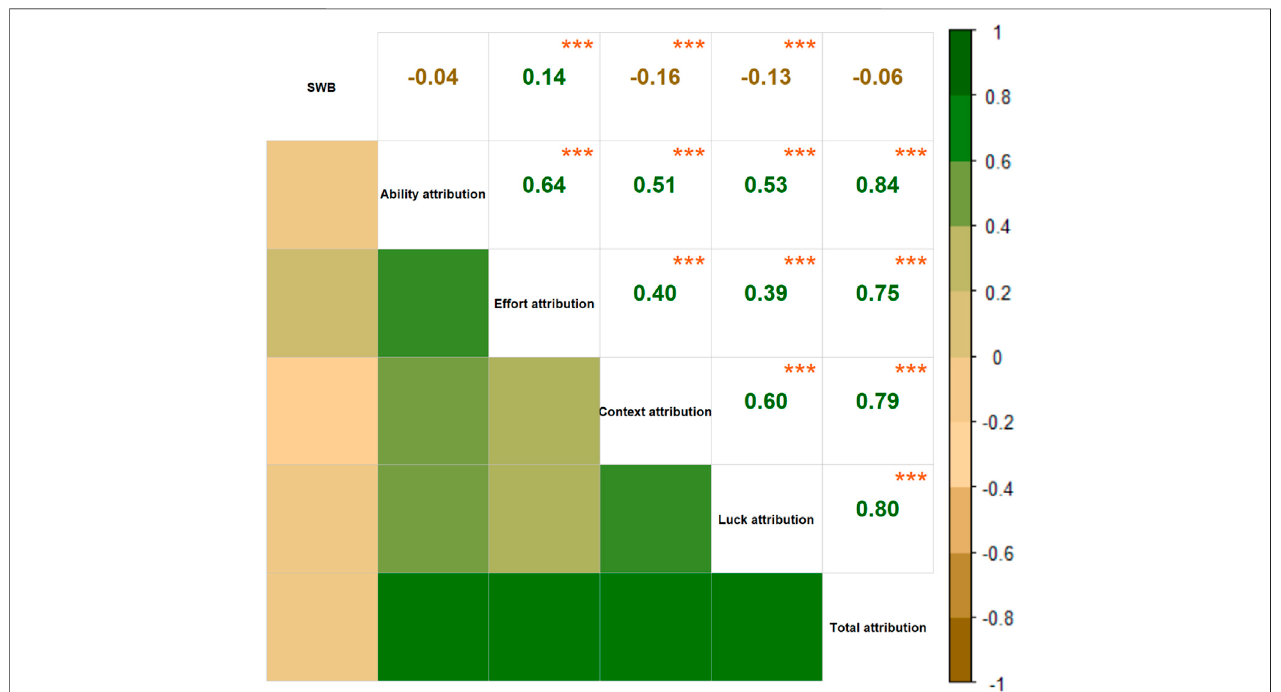
FIGURE 1 | Heat map illustrating correlations between subjective well-being and attributional style. The values in the upper triangular matrix are correlation coef fi cients. In the lower triangular matrix, the darker the color is, the stronger correlation is. Positive correlations are shown in green, while negative correlations are shown in brown. Except for the correlation between subjective well-being and ability attribution and total attribution, the other correlation coef fi cients were signi fi cant at 0.001 level. *p < 0.05; **p < 0.01; ***p < 0.001.